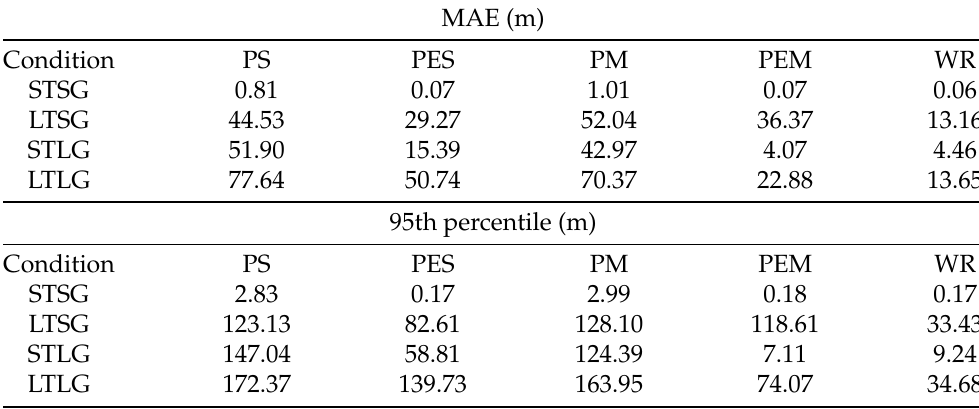
Table 1. Mean absolute error (MAE) and 95th percentile under different conditions in the simulation. MAE